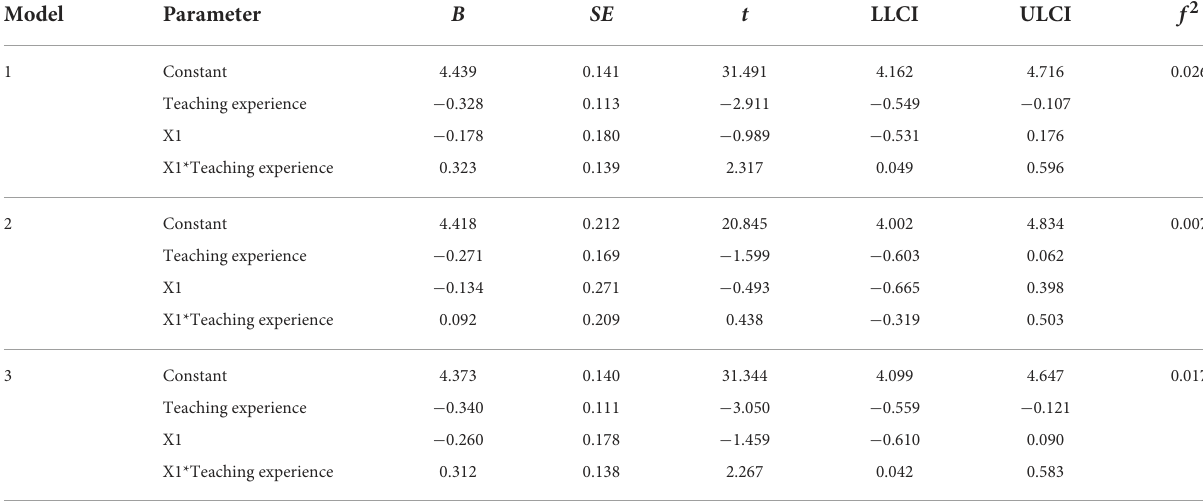
TABLE 4 Interaction effect of teachers’ gender in the relationship between teaching experience and self-efficacy beliefs in SBC implementation. Model Parameter